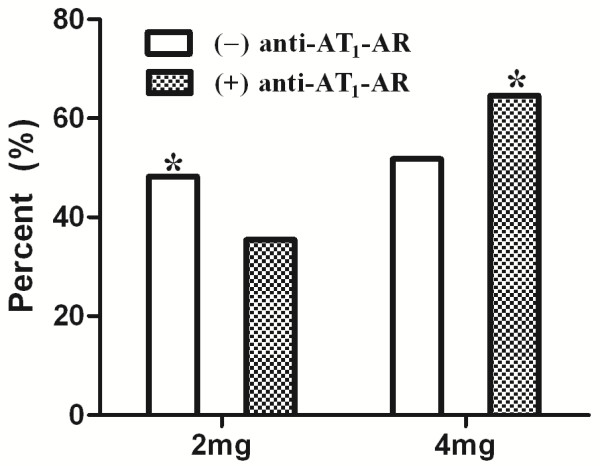
Perindopril dosage. During the one-year treatment period, the mean perindopril dose in the (+) anti-AT1-AR and (−) anti-AT1-AR group was 3.3 ± 0.1 mg Qd /day and 2.9 ± 0.1 mg Qd/day (P <0.05), respectively. Perindopril (4 mg) was administered to patients with (+) anti-AT1-AR at significantly higher doses than patients with (−) anti-AT1-AR (P < 0.05, 64.6% vs. 44.6%). These results suggest that the patients with (+) anti-AT1-AR are more tolerant to perindopril than those that do not express these autoantibodies.